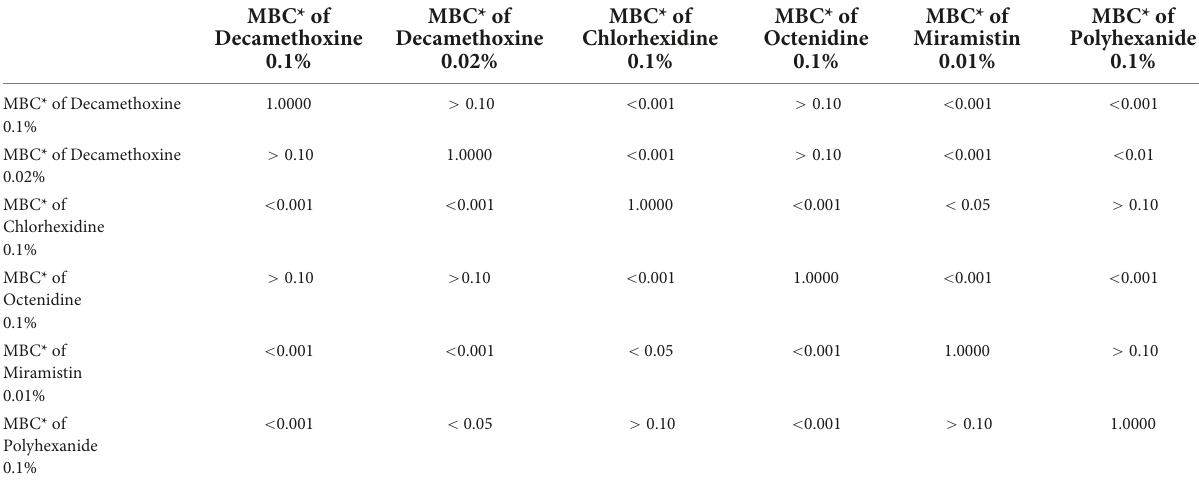
MBC* of MBC* of MBC* of MBC* of MBC* of MBC* of Decamethoxine Decamethoxine Chlorhexidine Octenidine Miramistin Polyhexanide 0.1% 0.02% 0.1% 0.1% 0.01% 0.1% 1.0000 > 0.10 <